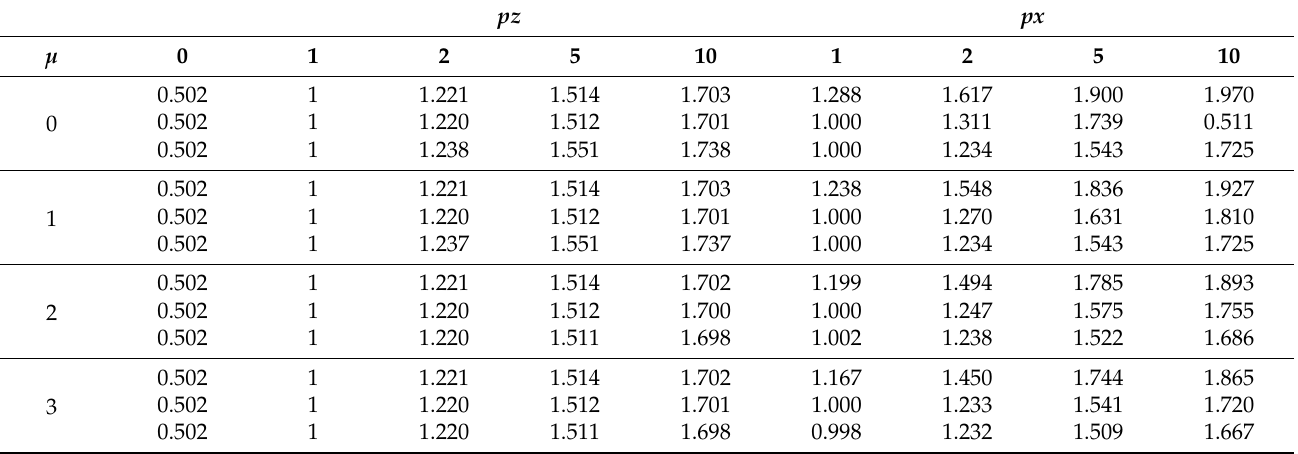
Table 8. Relation between nondimensional first three natural frequencies ( Ω adim ) of SS FGM2 and FGM1 beams, using aluminium as reference. L/h =